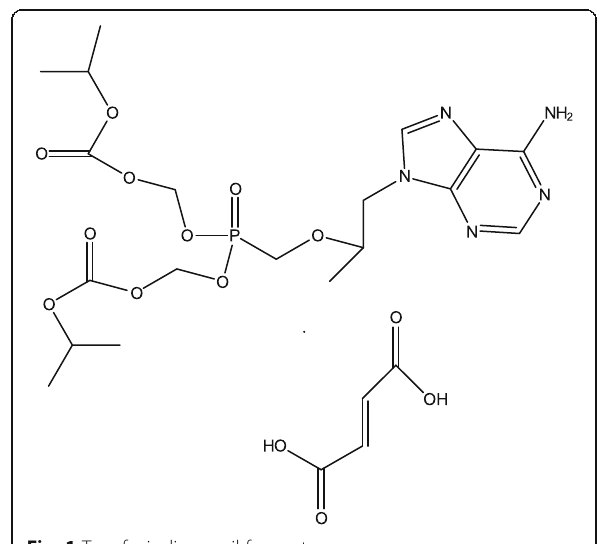
Fig. 1 Tenofovir disoproxil